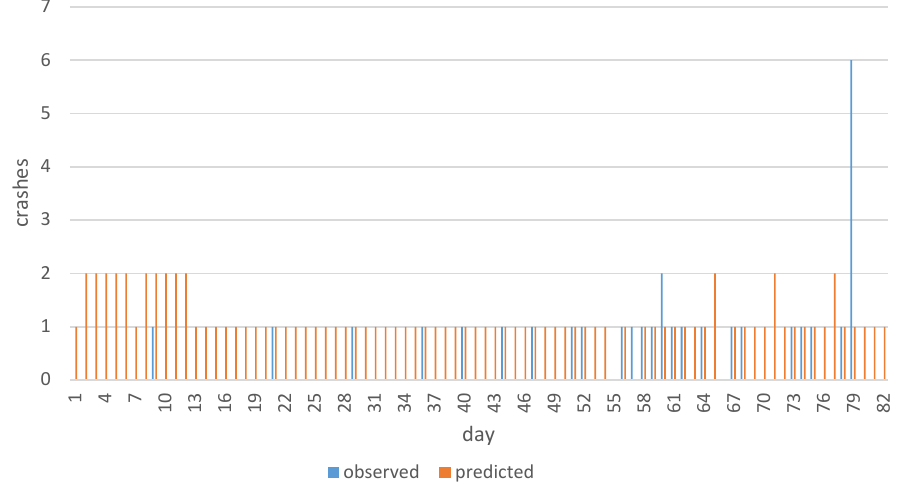
Figure 12. Prediction in Soochow direction of SVR.